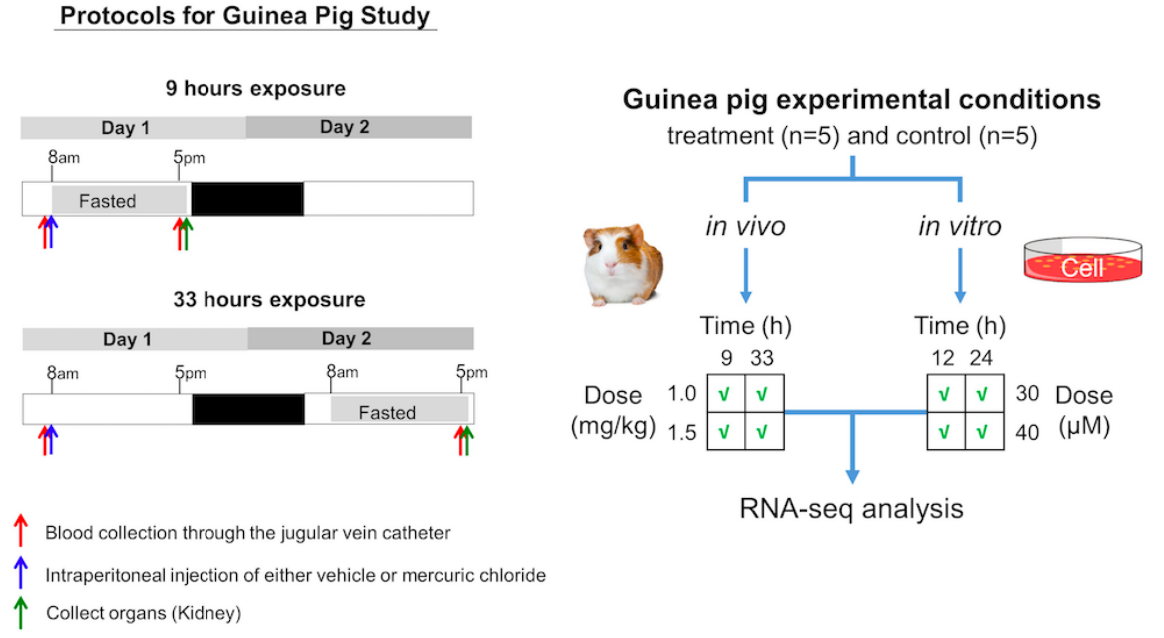
Figure 7. Summary of the experimental conditions used in the guinea pig mercuric chloride exposure studies for either in vivo animal or in vitro cell-based studies.